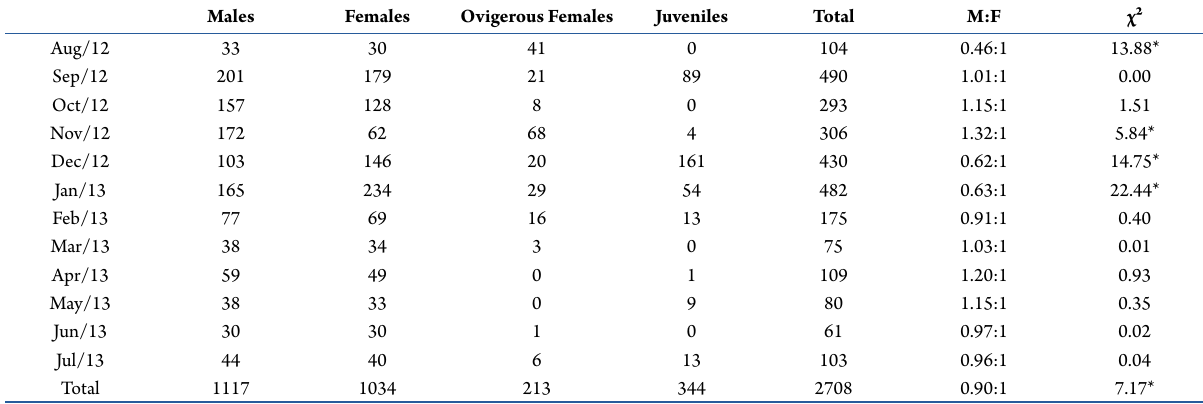
Table 1 . Number of specimens sampled monthly for a year, monthly sex ratio and goodness of fit analysis ( χ ²) of Hyalella georginae , Palmeira das Missões, state of Rio Grande do Sul, Brazil.